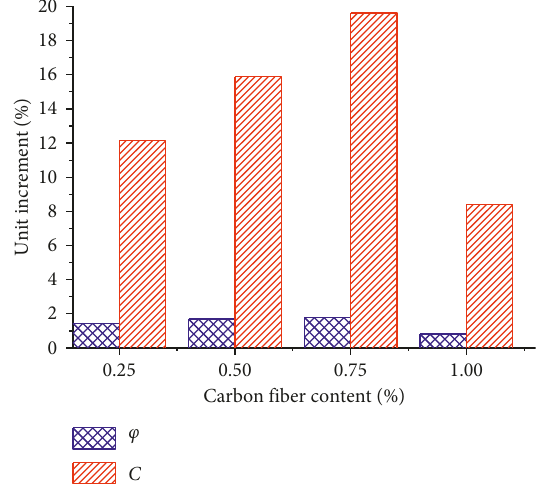
8: Incremental shear strength parameters of the specimen with different carbon fiber content.